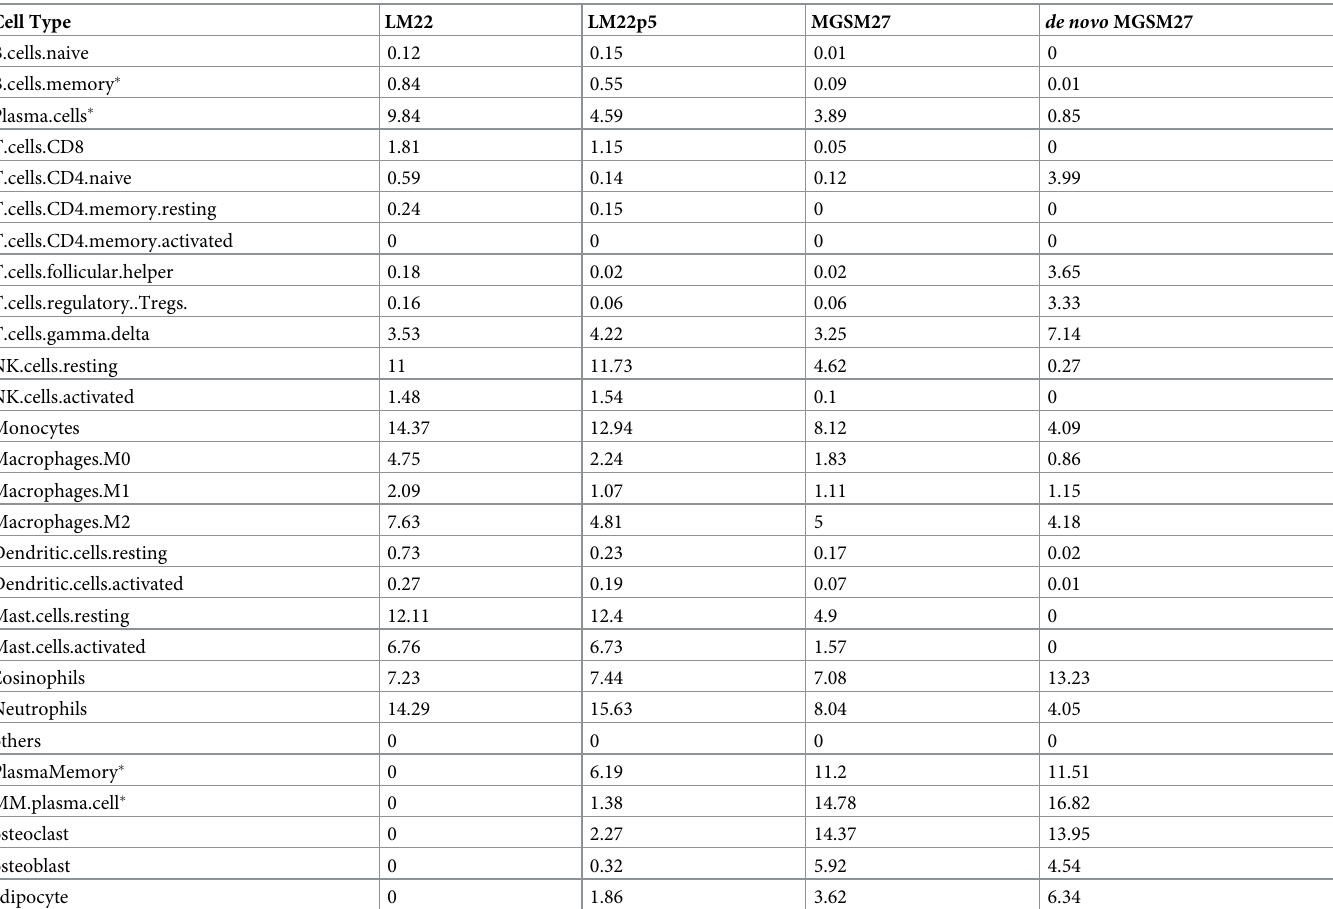
Table 3. Deconvolution of WBM